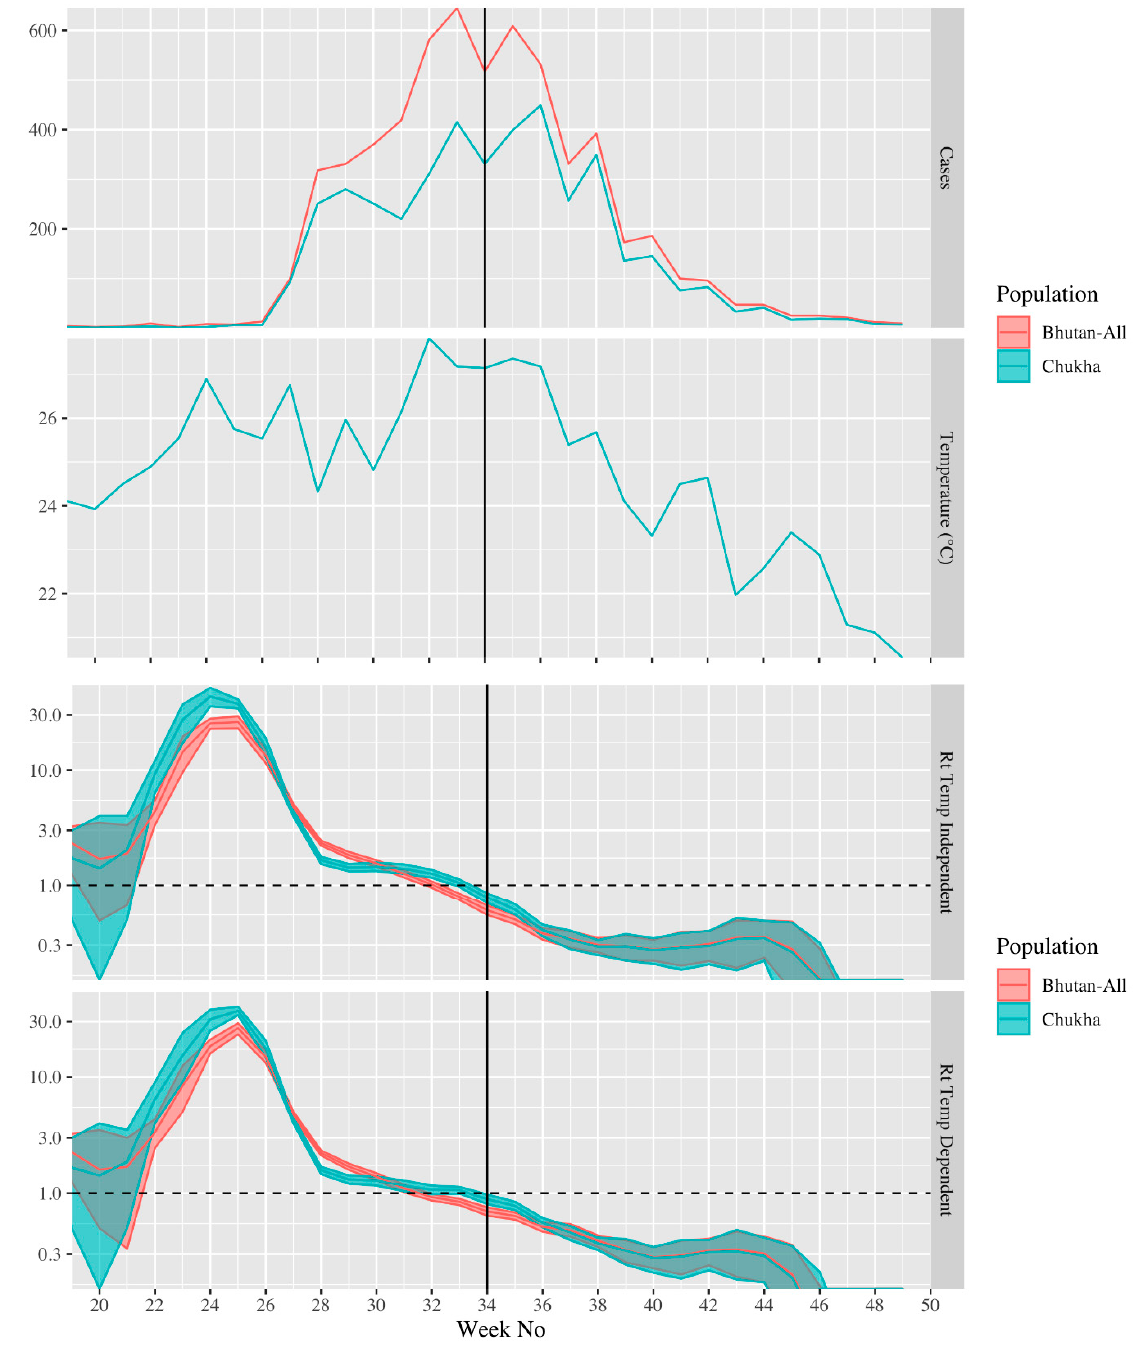
Figure 4. From top to bottom: the number of dengue cases reported in National Early Warning, Alert, Response and Surveillance (NEWARS) each week in all of Bhutan and Chukha only; the weekly average temperature (°C) in Chukha; the effective reproduction number for cases developing symptoms in each week, assuming constant temperature over the period; the effective reproduction number for cases developing symptoms in each week, accounting for changes in temperature over the epidemic. The solid vertical line indicates the start of interventions in week 34. The dashed horizontal line in the bottom two panels indicates the critical value of the effective reproduction number (1.0). In the bottom two panels, the shaded regions indicate 95% confidence intervals and the y -axis is on a log-scale for clarity.